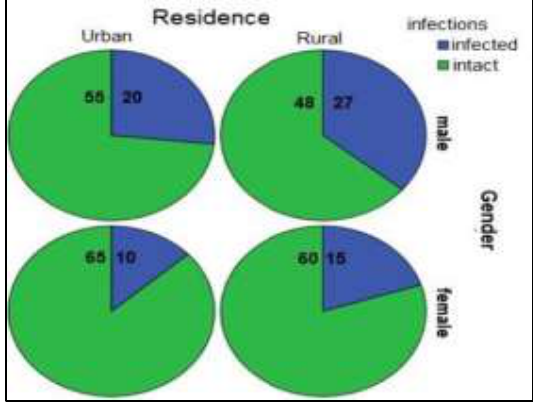
Figure 2. The prevalence of MRSA Nasal carriage among male and female in urban and rural schools